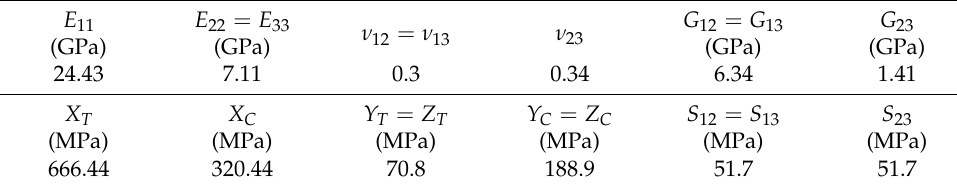
Table 3. Material properties of GFRP